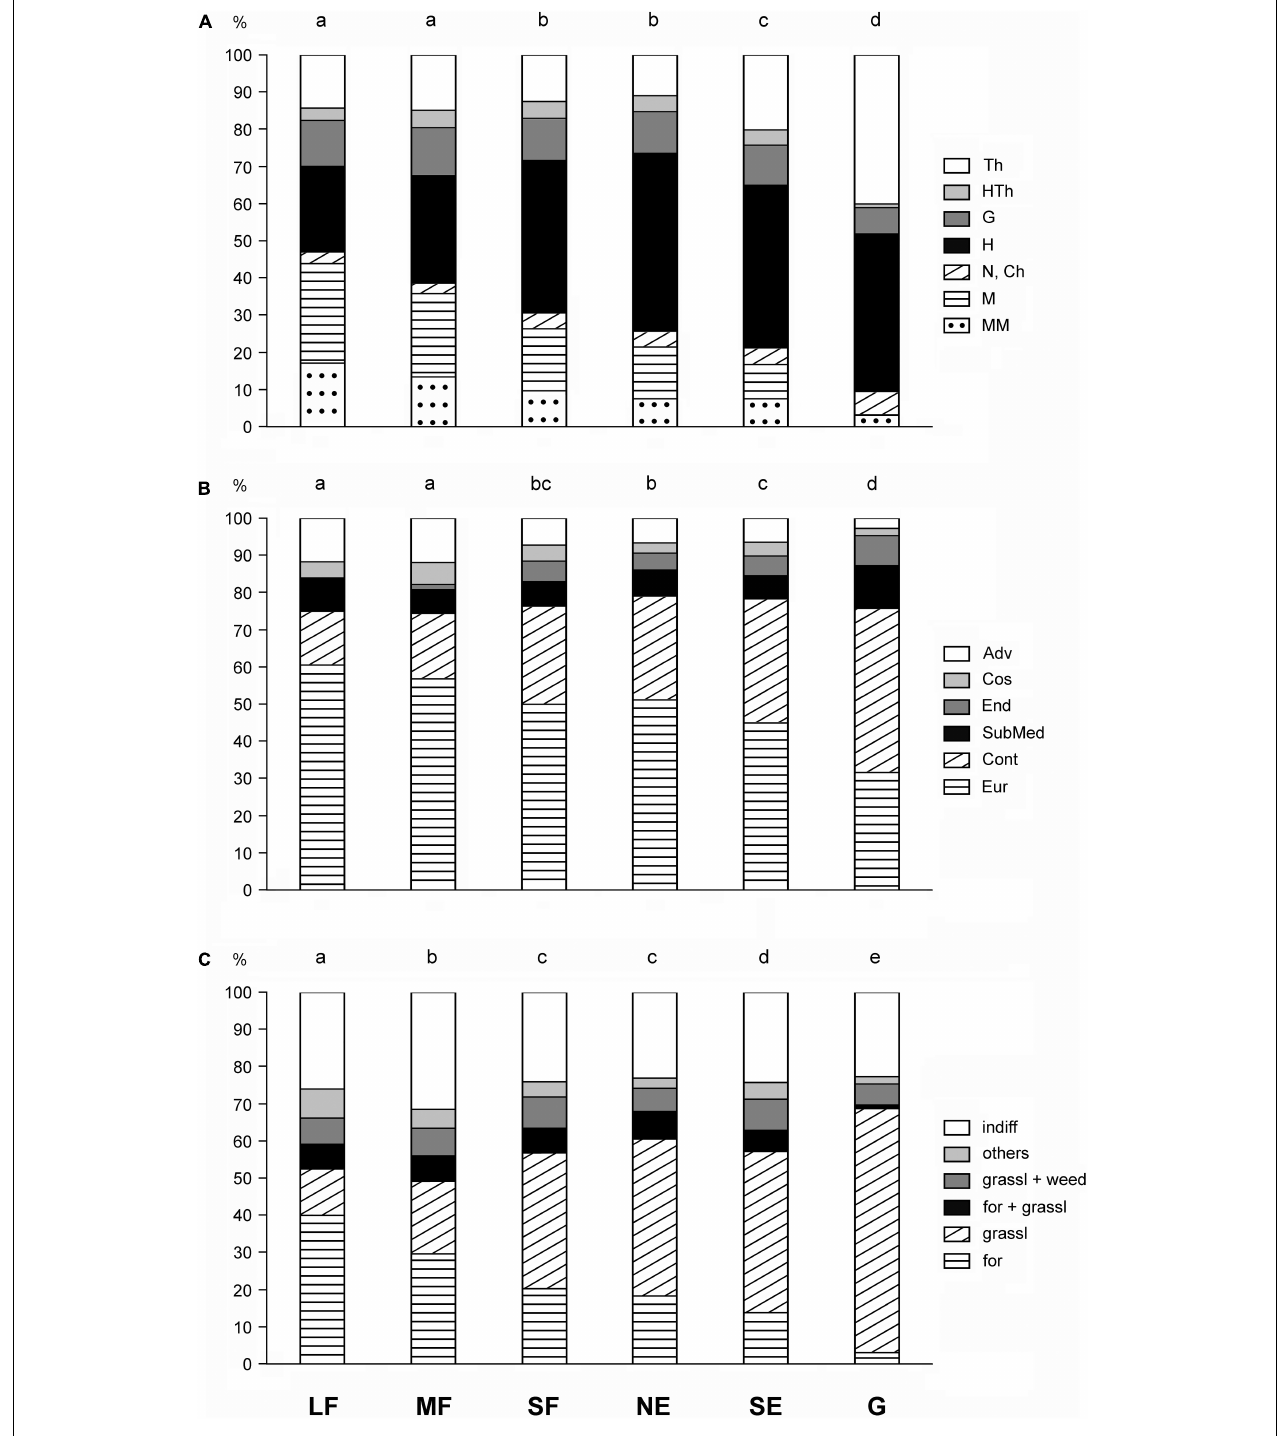
FIGURE 4 | Frequency distributions for (A) life-form categories, (B) geoelement types, and (C) phytosociological preference groups of the six studied habitats. Th, therophytes; HTh, hemitherophytes; G, geophytes; H, hemicryptophytes; N, nanophanerophytes; Ch, chamaephytes; M, microphanerophytes; MM, meso- and megaphanerophytes; Adv, adventives; Cos, cosmopolitans; End, endemics; SubMed, submediterranean species; Cont, continental species; Eur, European and Eurasian species; indiff, indifferent species; others, species of edges, scrubs, and disturbed communities; grassl weed, species related to grasslands and weed communities; for grassl, species commonly found in forests and grasslands; grassl, grassland-related species; for, forest-related species; LF, large forest patches; MF, medium forest patches; SF, small forest patches; NE, north-facing edges; SE, south-facing edges; G, grasslands. The habitats not sharing a letter over the bars are significantly